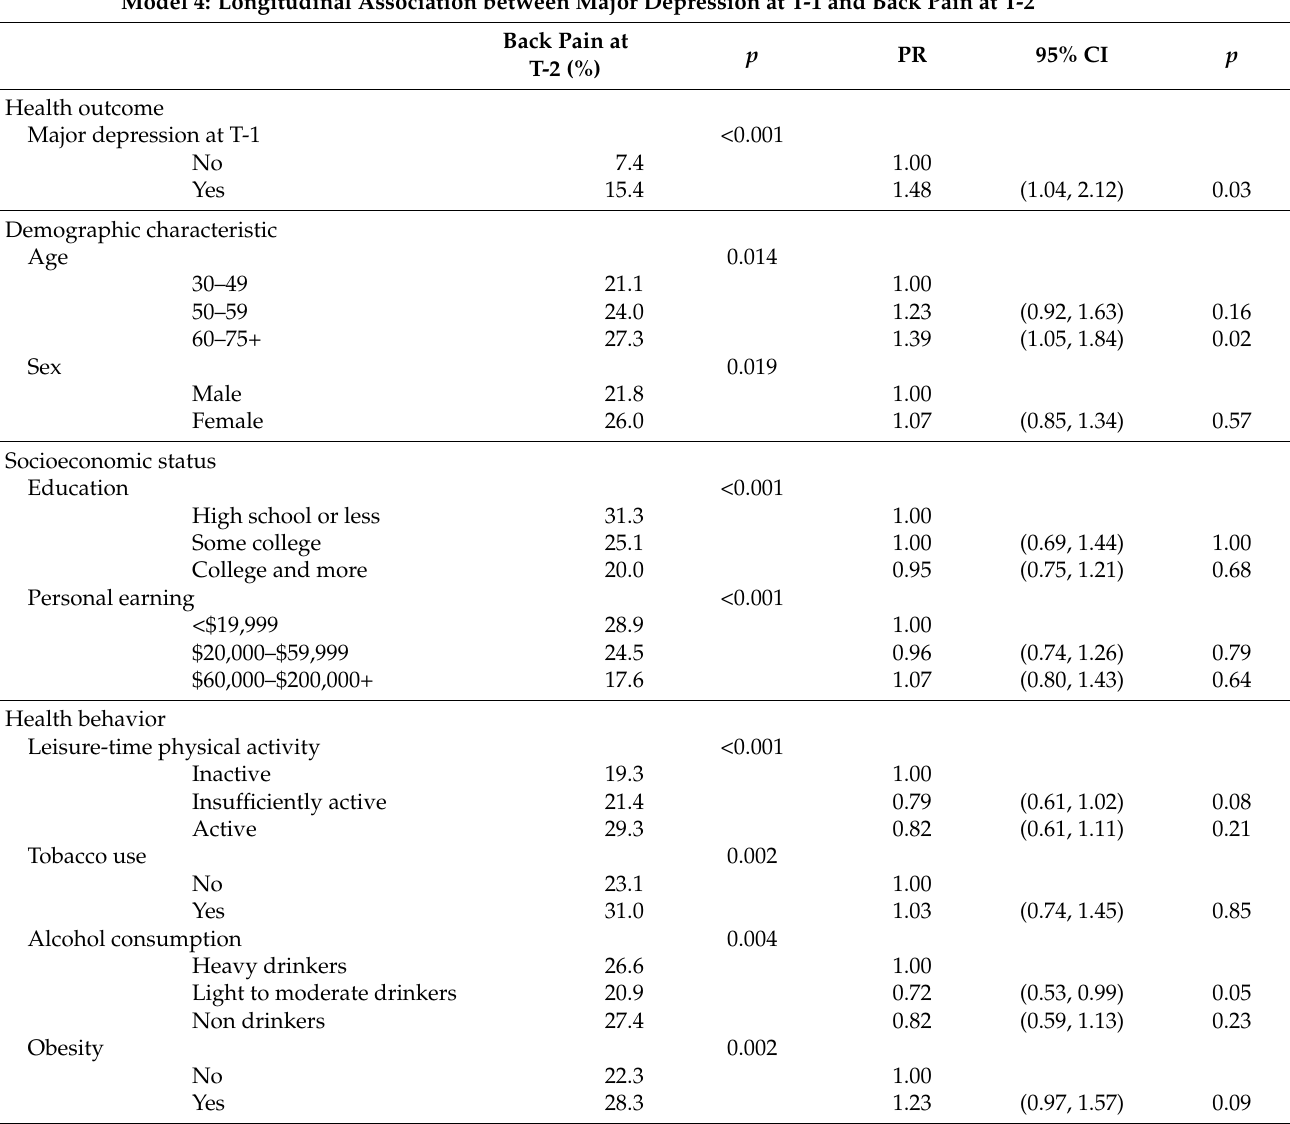
Table 4. Prevalence of back pain at T-2 by characteristics of the study sample at T-1 and longitudinal association between major depression at T-1 and back pain at